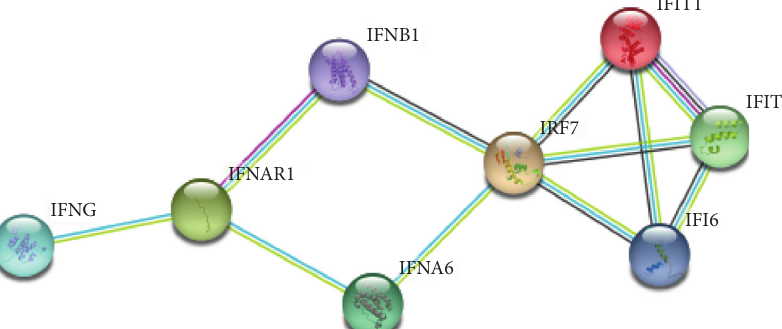
Figure 13: PPI involved in the interferon response obtained from the STRING database with an interaction confidence score of